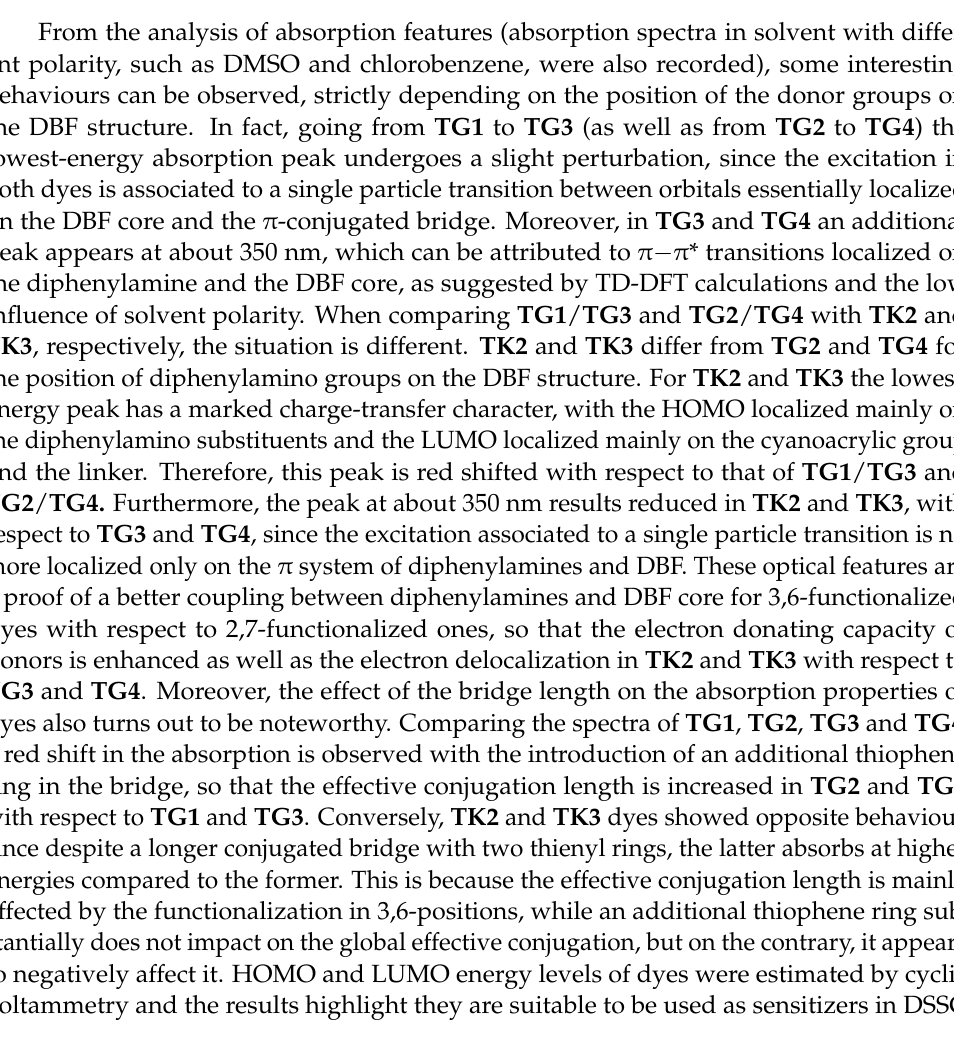
Figure 8. Molar absorption spectra of dyes TG1, TG2, TG3, TG4, TK2 and TK3 in CH 2 Cl 2 solution. Reprinted (adapted) with permission from ref. [105]. Copyright {2017} Clearance Center’s RightsLink of Spring Nature.